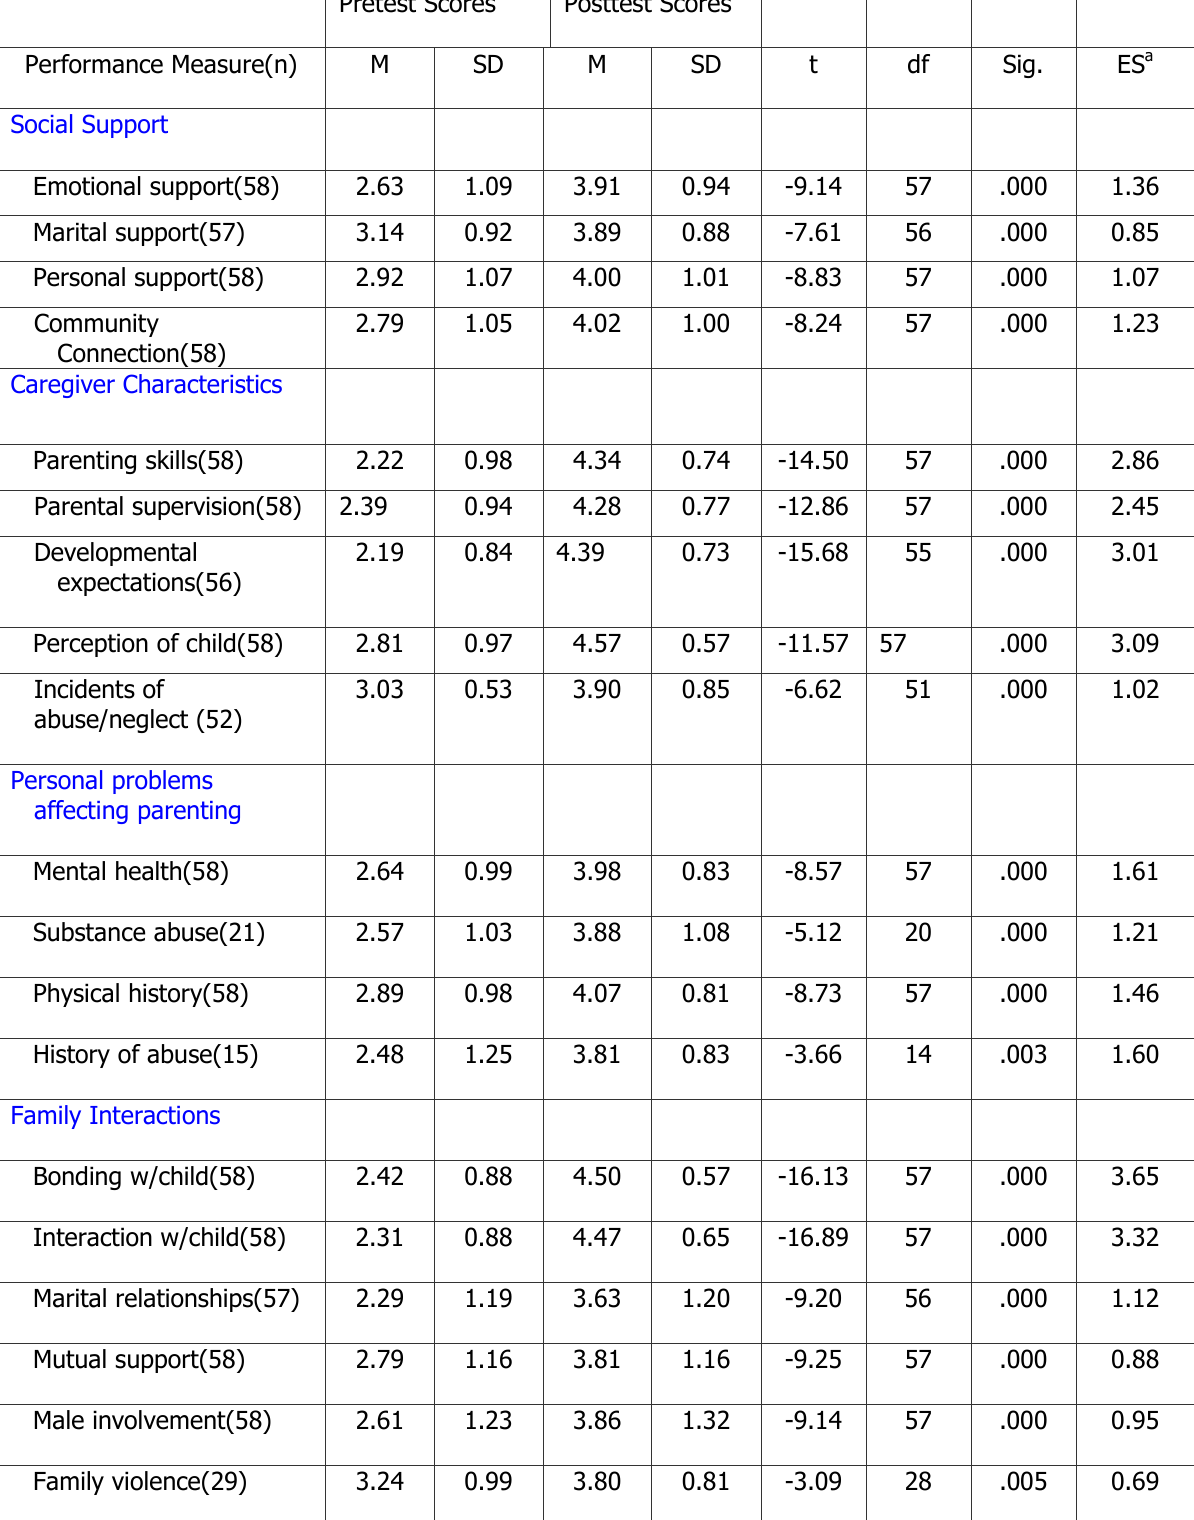
Results of Paired t Test of Outcome Measurements for Postpartum Period